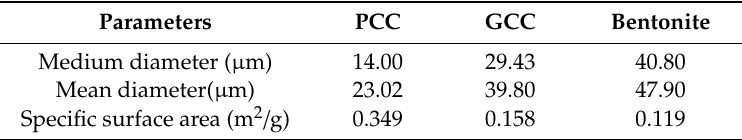
Table 1. Physical parameters of fillers.